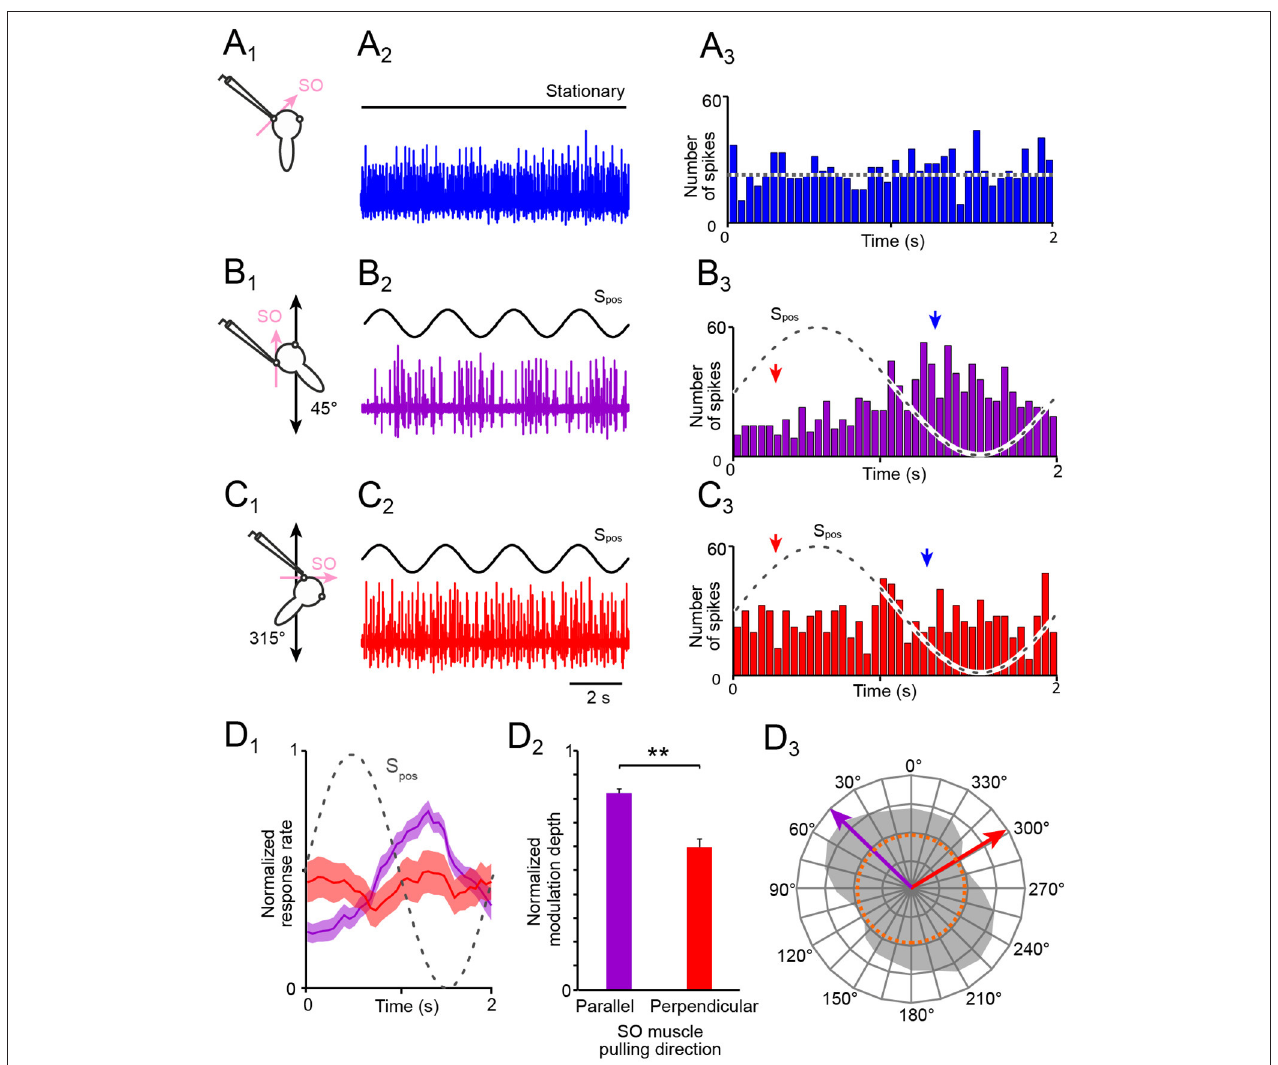
FIGURE 2 | Spontaneous and motion-induced spike discharge of the SO nerve. (A–C) Multi-unit activity of the left SO nerve (color-coded traces in A 2 ,B 2 ,C 2 ) in the absence of motion (A 1,2 ) and during four cycles of sinusoidal horizontal linear translation on a sled (S pos ; black traces in B,C ) at 0.5Hz and 0.49 m/s 2 peak acceleration; preparations were positioned on the sled such that the SO muscle was oriented parallel (B 1 ) or perpendicular (C 1 ) to the translational motion direction; PSTHs (bin width: 50ms) of spontaneous (A 3 ) and averaged SO nerve firing rates over a single cycle (dashed sine waves) of sled motion (from n = 20–30 cycles), respectively (B 3 ,C 3 ) ; the dotted line in (A 3 ) indicates the average resting rate and the arrow heads in (B 3 ,C 3 ) the phase-time of the minimal (red) and maximal (blue) discharge. (D) Mean ± SEM of averaged SO nerve discharge modulation ( D 1 ; n = 8 preparations) over a single cycle (dashed sine wave) during linear motion parallel (violet) and perpendicular (red) to the SO muscle pulling direction; bar plot (D 2 ) of normalized SO nerve firing rate modulation during translation parallel (violet) and perpendicular (red) to the SO eye muscle pulling direction ( n = 8); significance of difference between the normalized response rates during motion in the two directions is indicated (** p ≤ 0.01; Wilcoxon signed-rank test); polar plot (D 3 ) depicting the directional distribution of SO nerve discharge modulation magnitudes across 360 ◦ of translational motion (gray area) and preferential (violet arrow) and approximately orthogonal response vectors (red arrow); the dotted orange circle in D 3 indicates the average resting rate. SO, superior oblique; S pos , stimulus position of the